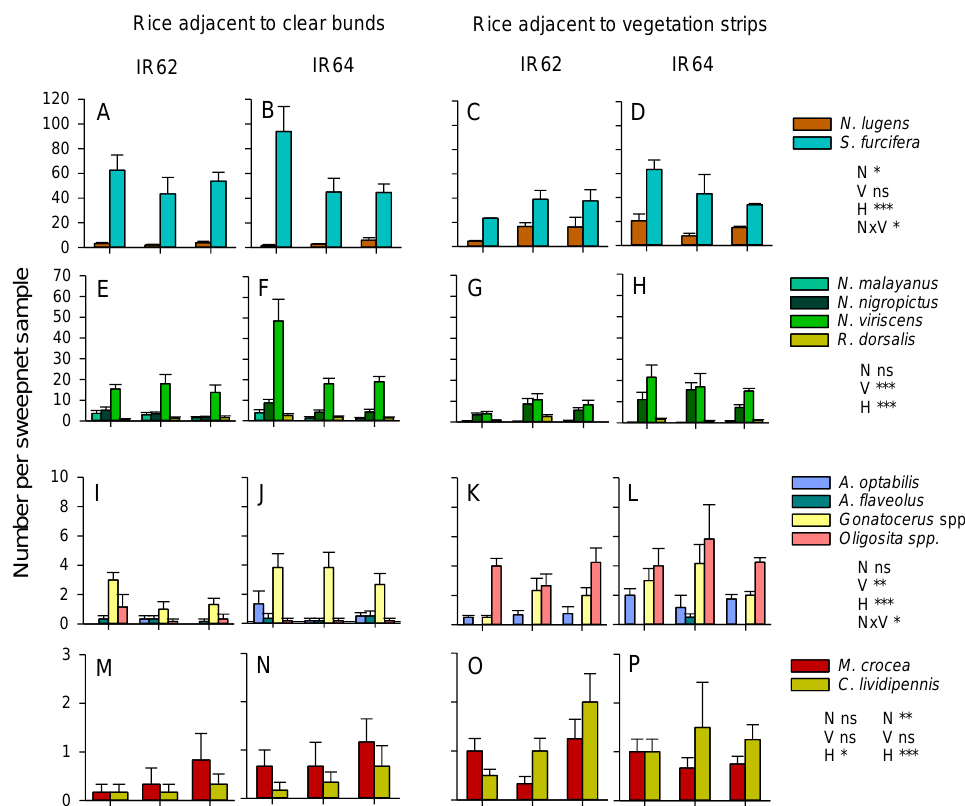
Figure 10. Relative abundance of planthoppers, leafhoppers and their specialist natural enemies in rice plots adjacent to clear bunds (A,B,E,F,I,J,M,N) and mung bean bunds (C,D,G,H,K,L,O,P) during the early crop stage (August) of the 2013 wet season. Plots were treated with one of three levels of nitrogen (N1, N2, N3) and planted with IR62 (resistant, A,C,E,G,I,K,M,O) or IR64 (susceptible, B,D,F,H,J,L,N,P) rice varieties. Graphs indicate the abundance of planthoppers ( N. lugens and S. furcifera ) ( A – D ), leafhopper vectors of tungro virus ( N. malayanus , N. negropictus , N. virescens and R. dorsalis ) ( E – H ), egg parasitoids ( A. optabilis , A. flaveolus , Gonatocerus spp. and Oligosita spp.) ( I – L ), and two specialist predators ( M. crocea and C. lividipennis ) ( N – P ). Standard errors are indicated ( n = 6). Multiple GLM results for the effects of nitrogen (N), variety (V), bund type (H) and their significant interactions (N × V) on all species are presented in the text. Between group effects are indicated below the legends for each species group, except predators where results for M. crocea (on left) and C. lividipennis (on right) are presented separately. ns = p > 0.05, * = p < 0.05, ** = p = 0.01, *** = p < 0.005.